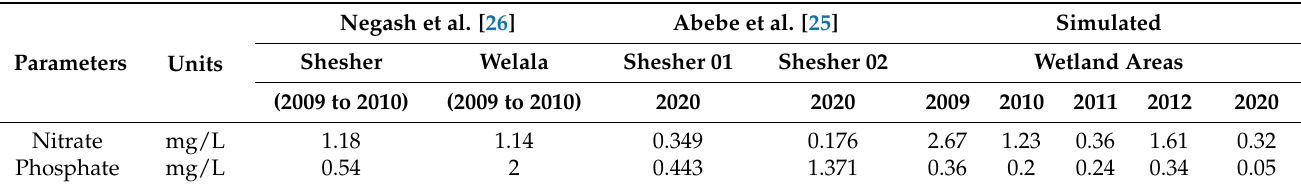
Table 11. Water quality status of the Welala and Shesher wetlands in the Fogera floodplain from different studies. Note: Shesher 01 and 02 are two sampling points in the wetland where a river comes in and out.